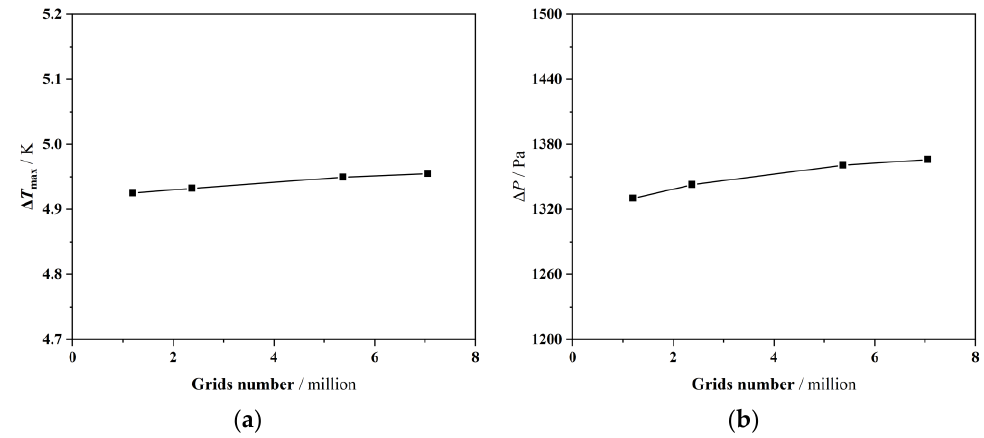
Figure 5. The effects of grid number on the numerically solved results: ( a ) Maximum temperature difference; ( b ) Pressure drop.